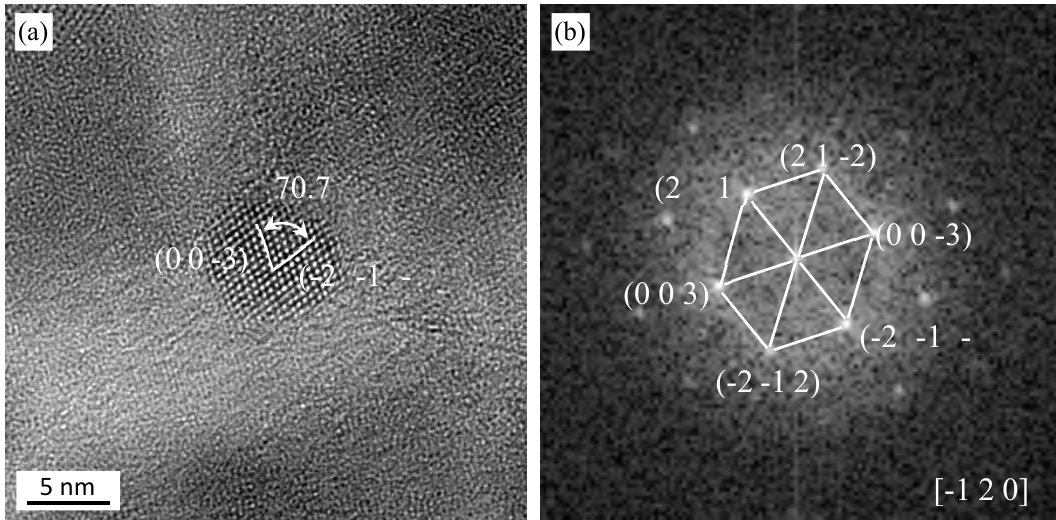
Figure 5. ( a ) HRTEM micrograph of Y 4 Zr 3 O 12 from a sample after TMP, ( b ) FFT (fast Fourier transform) diagram of the micrograph in ( a ).